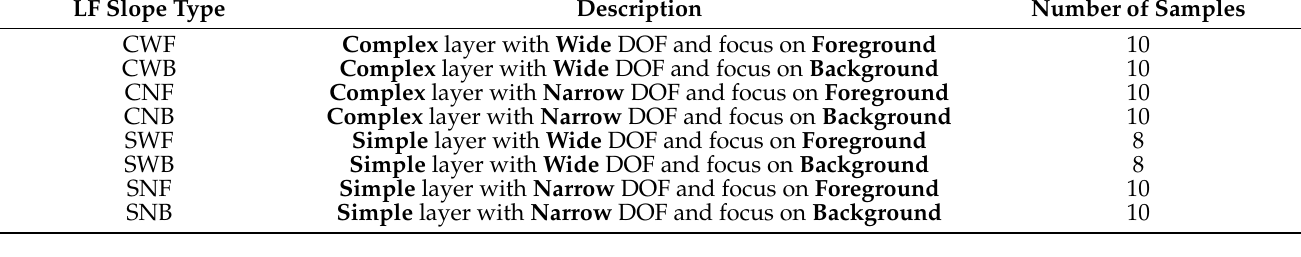
Table 1. Overview of LF data definition.